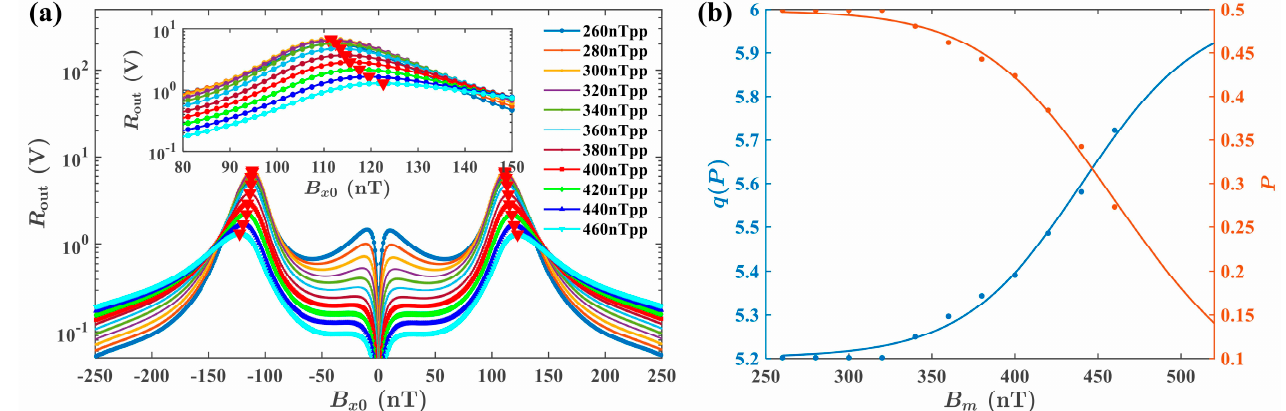
Figure 5. ( a ) Magnetometer response when sweeping the magnetic field offset along the x -axis B x 0 with different B m values ranging from 260 nT peak-peak value to 460 nT peak-peak value, and the ω m /2 π fixed at 600 Hz. The peak of each first-order resonance is marked with red inverted triangles and recorded. ( b ) The slowing-down factor q ( P ) and spin polarization P when different B m values are employed, wherein each record is extracted from the data depicted in subfigure ( a ). The solid circle points represent the experimental data, whereas each solid curve represents the fit curve according to Equation (14).